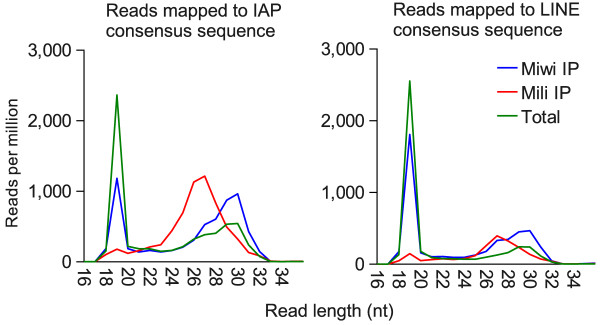
Miwi and Mili IP small RNA derived from IAP and LINE Deep sequencing reads from co-immunoprecipitated (IP) small RNAs were mapped to an IAP consensus sequence and a LINE consensus sequence. Each plot was normalised to reads per million mappable reads in the library.